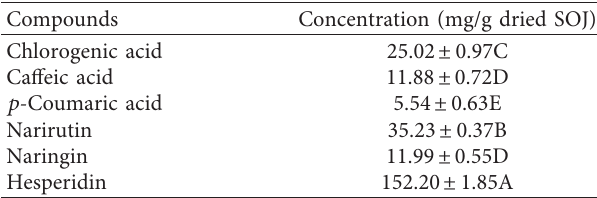
Table 1: Phenolic compounds of Shahpouri orange juice (SOJ).